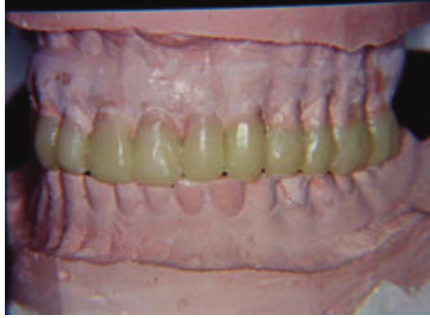
Figure 3: Waxing of the maxillary cast for manufacturing a maxillary occlusal splint for a 7 mm increase in